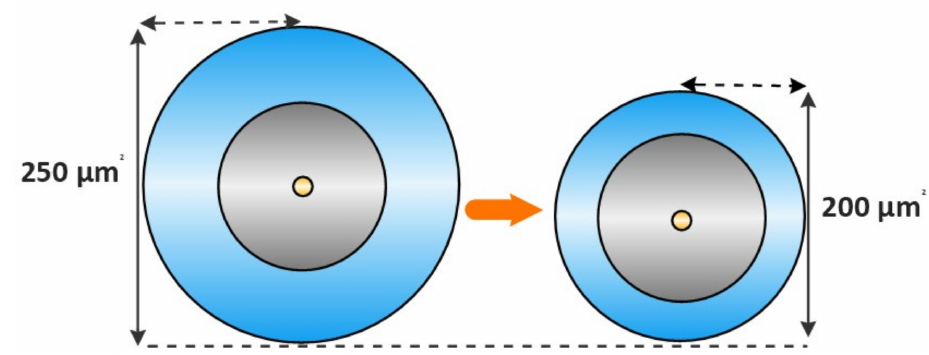
Figure 37. Comparison of recent and future fiber coating